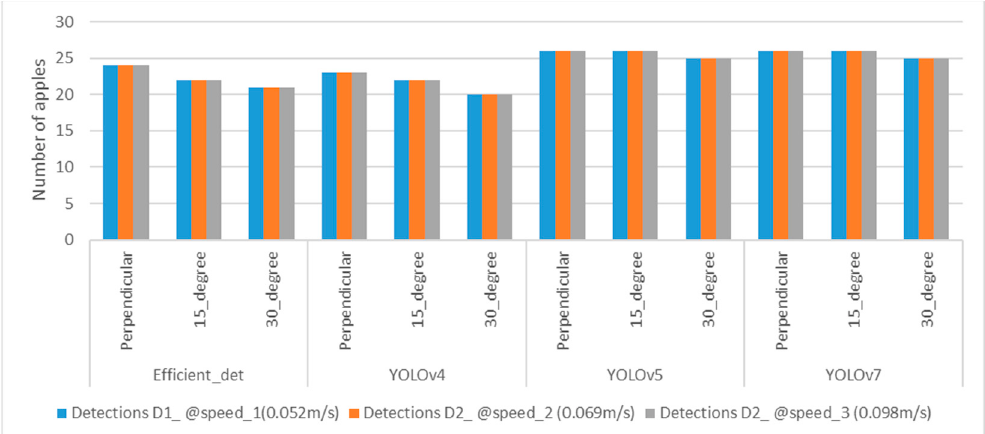
Figure 20. Number of apples detected out of 30 for different orientation angles and deep learning